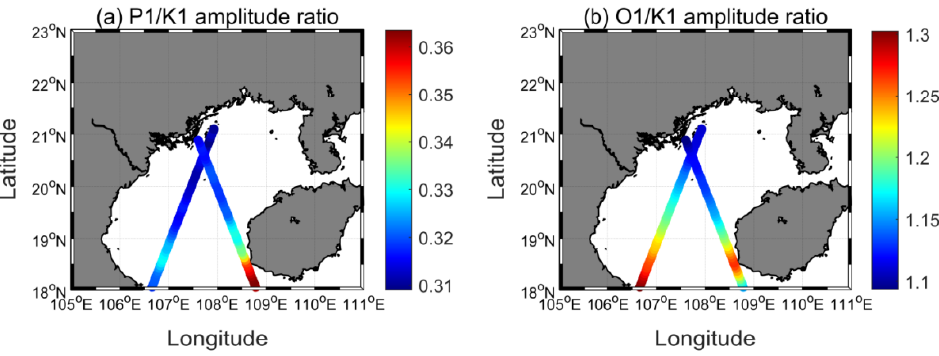
Figure 5. Amplitude ratios from T/P-Jason observations in the Gulf of Tonkin: ( a ) P 1 /K 1 , ( b ) O 1 /K